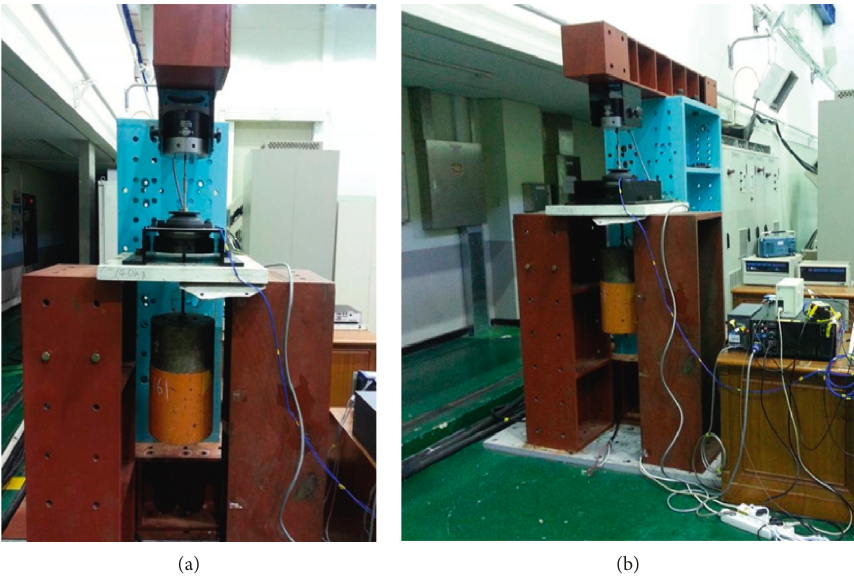
Figure 14: Experimental setup for 2-DOF system with electromagnetic hybrid mount.